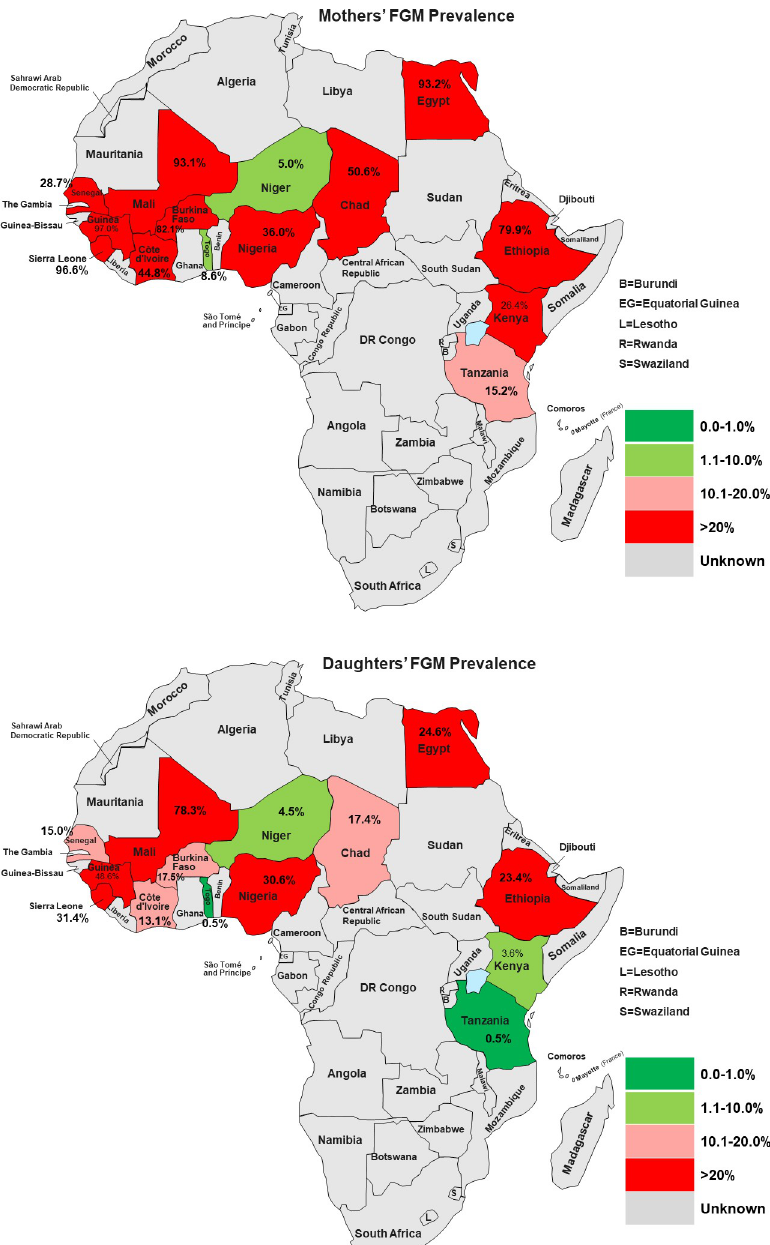
Fig 2. a: Prevalence of Mothers’ FGM in African Countries (Source: Authors drawing). b: Prevalence of Daughters’ FGM in African Countries (Source: Authors drawing).